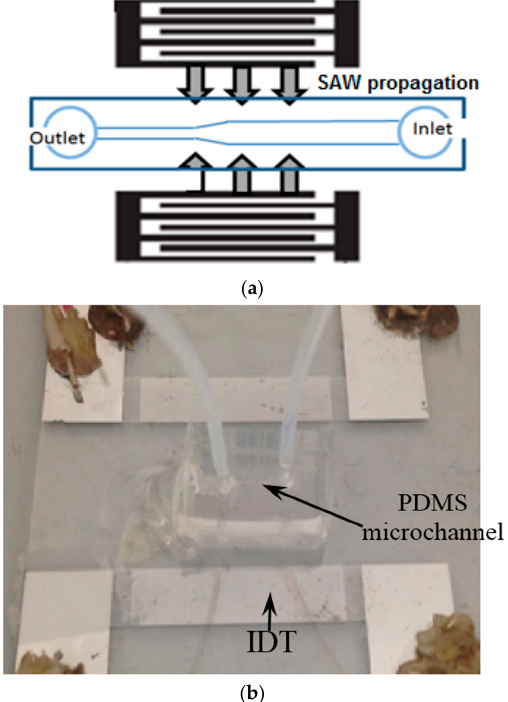
Figure 2. ( a ) Schematic diagram; and ( b ) photo of the SAW propagation through a PDMS microchannel with a constriction area in the experiment.